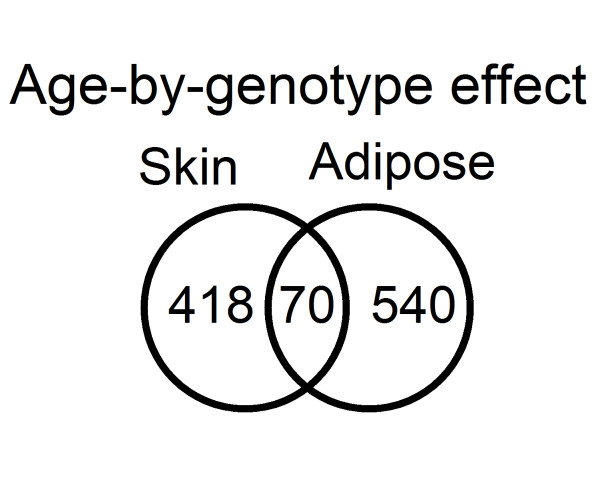
Venn diagrams showing the overlap in skin and adipose tissue for GxA interacting genes.